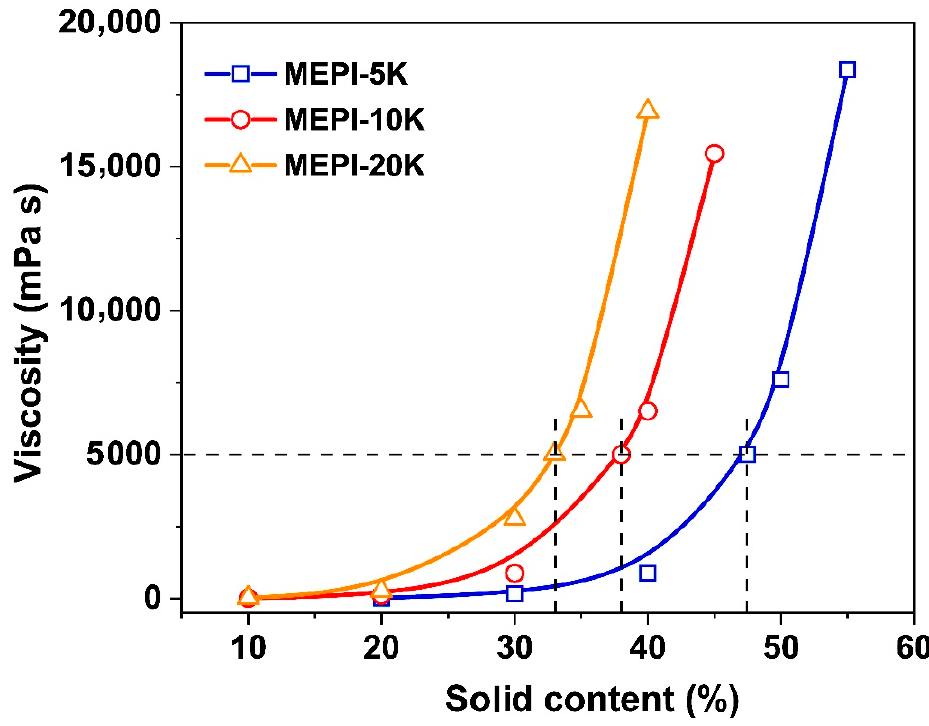
Figure 2. Viscosity-solid content relationship of METI solutions with DMAc as solvent at room tem- perature.